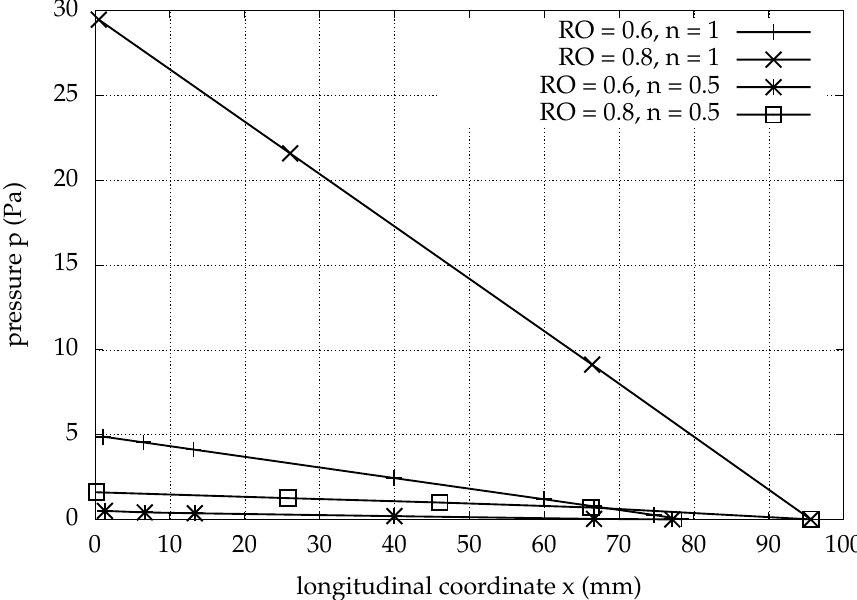
Figure 21. Peristalsis characteristics for roller pumps 90 mm long and one roller, moving with c = 5 mm/s, using linear scale for the